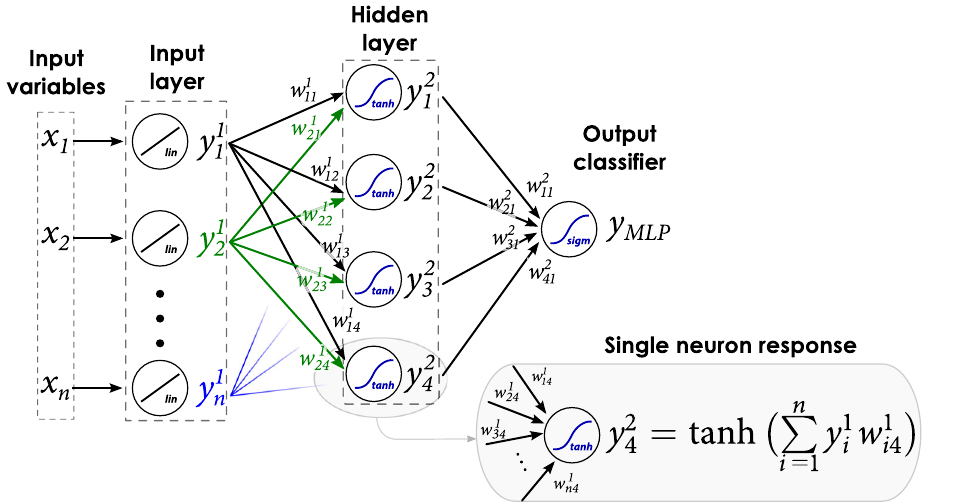
Fig. 4 Schematic drawing of multi-layer perceptron neural network (bias neurons were not shown for simplicity). The inset shows how a single neuron response is